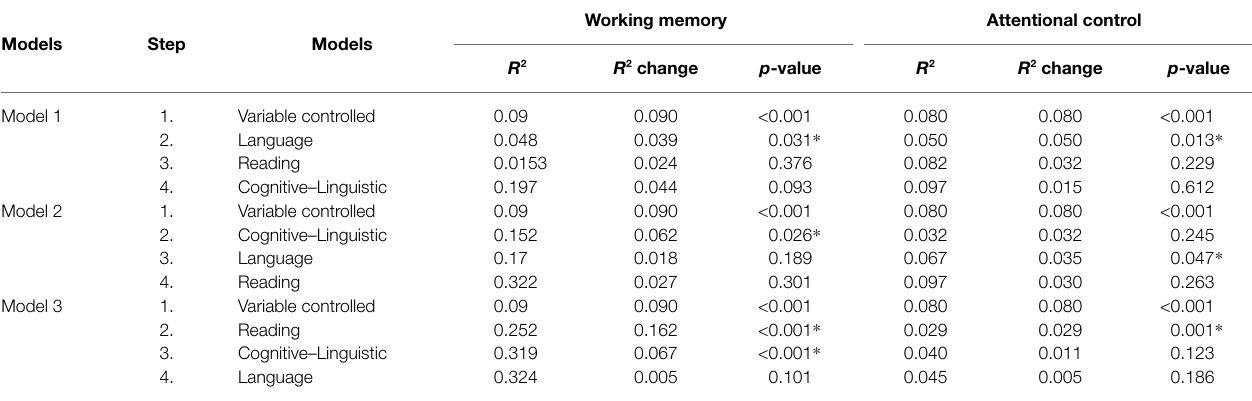
TABLE 6 | R 2 change of each block of predictors in three models using hierarchical multiple regression switch-order approach to explain variance on two measures of cognitive skills in grade 6.